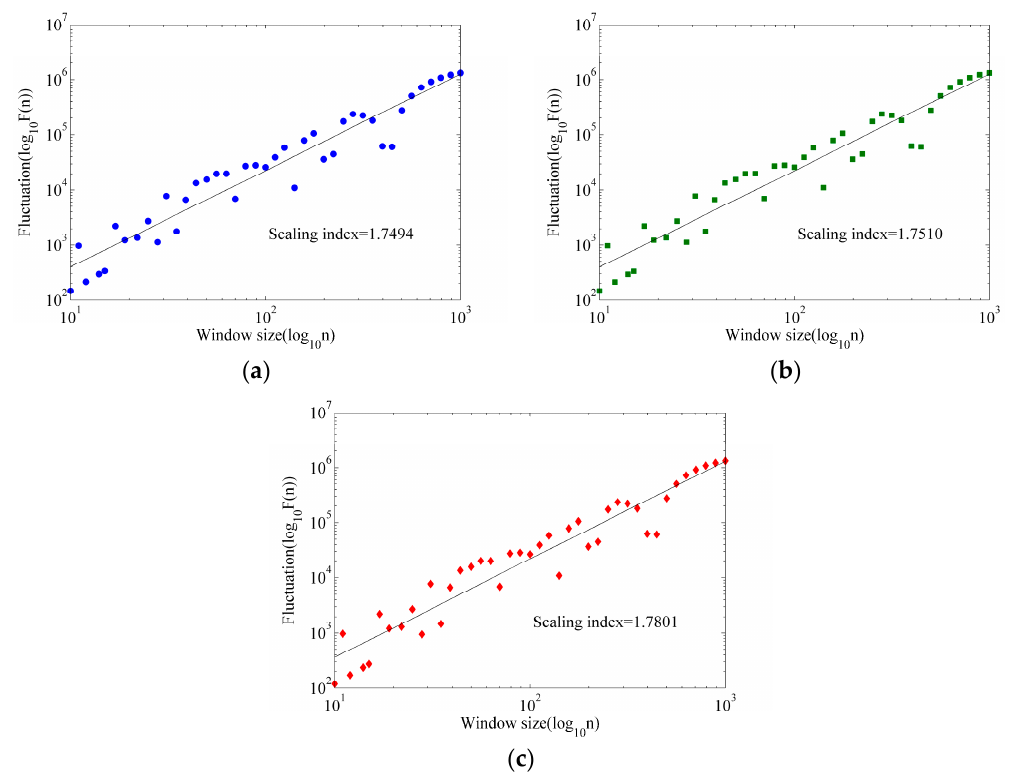
Figure 11. The scaling index α of four denoising methods. ( a ) Conventional CEEMDAN denoising 1. ( b ) Conventional CEEMDAN denoising 2. ( c ) ICEEMDAN denoising.